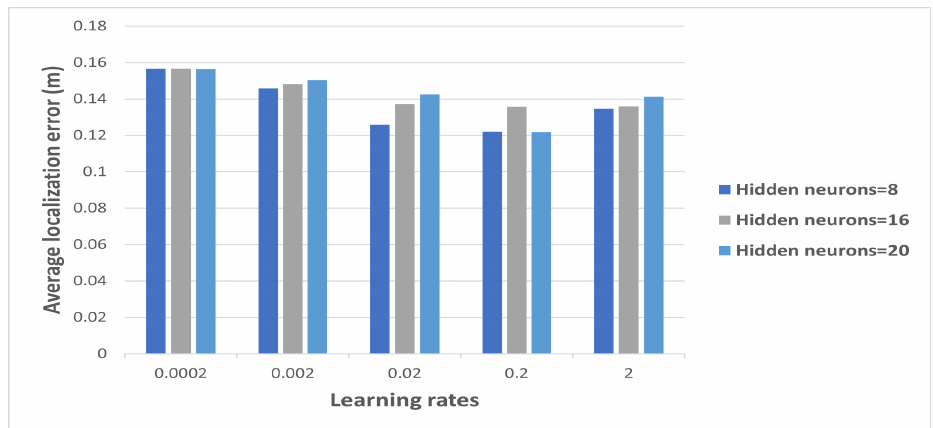
Figure 4. Localization accuracy of the used RNN network architectures with the considered learning rates in LOS. Table 1. Accuracy of the used RNN based localization architectures with the used learning rates in